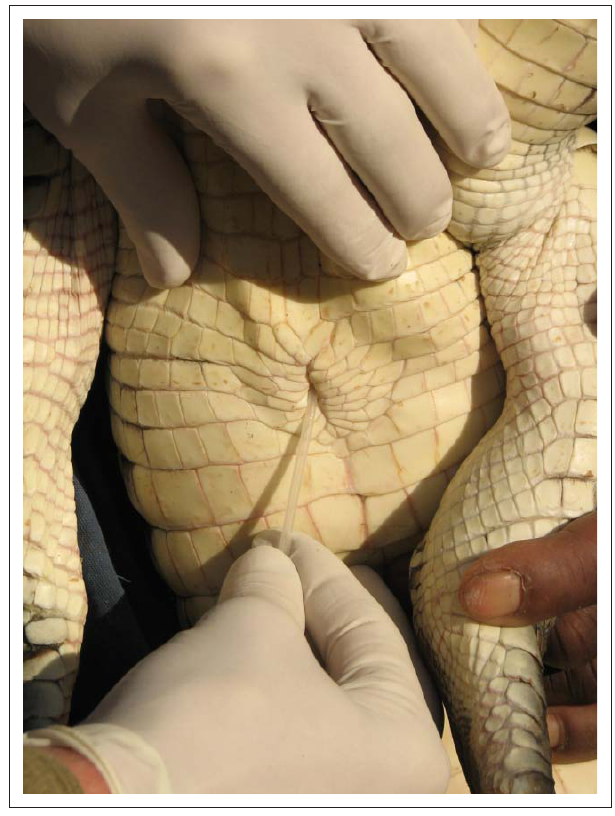
FIGURE 4: Inserting a French Gauge 10 canine urinary catheter into the cloaca through the vent, whilst the pre-slaughter size crocodile (± 1.5 m in total length) is held in a vertical position with the head